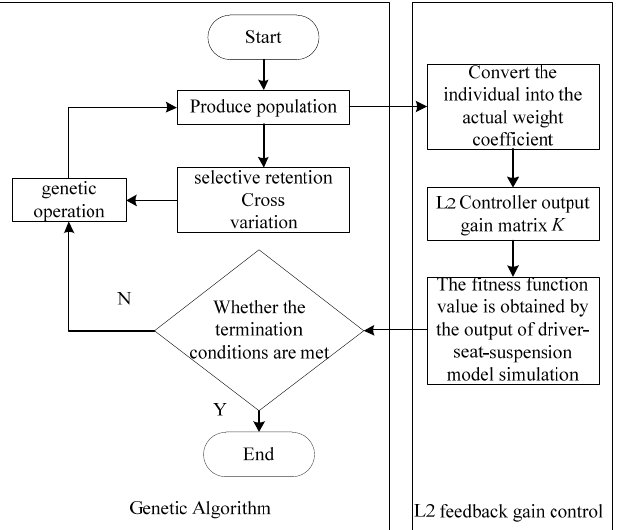
Figure 3. Schematic diagram of genetic algorithm.